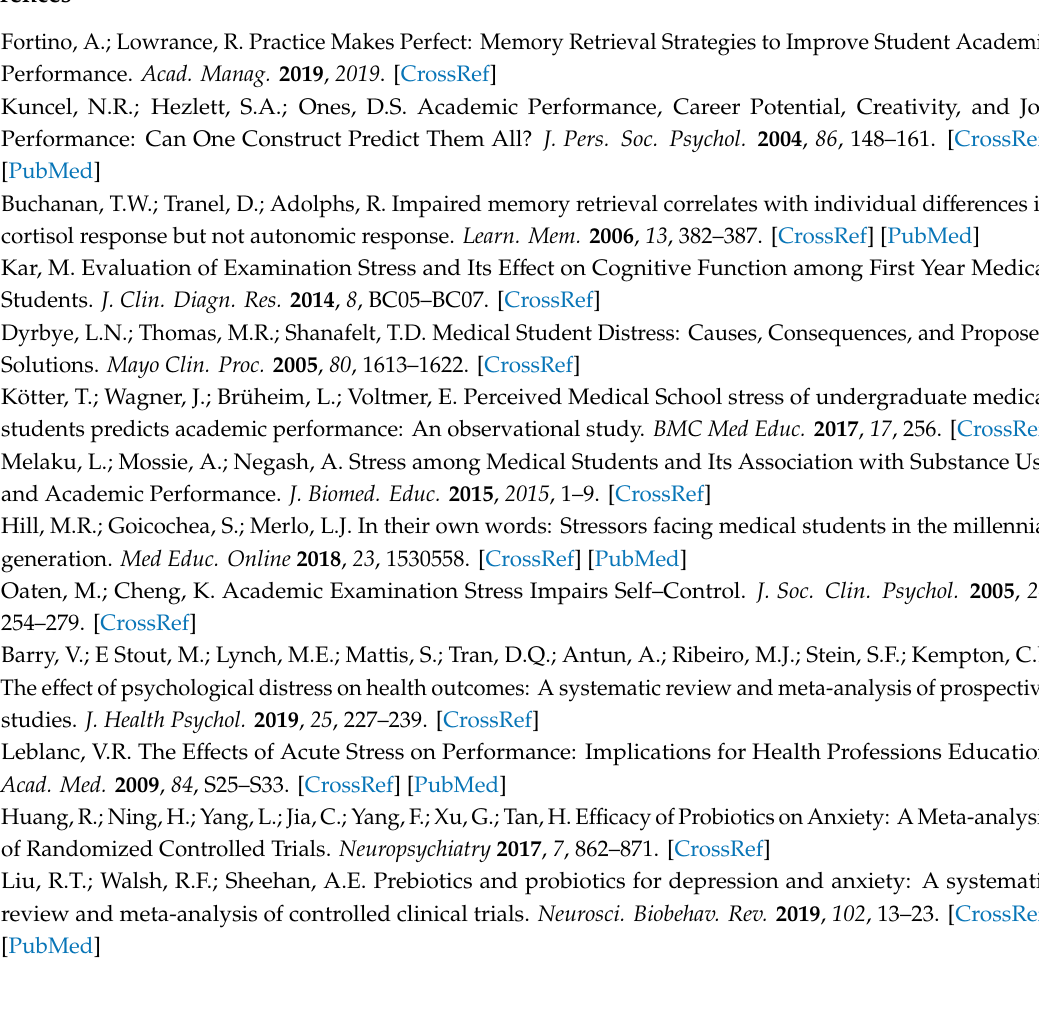
Figure S1: Association between self-reported consumption of fermented products and the e ff ect of Saccharomyces supplementation on increase in pulse rate under stress, Table